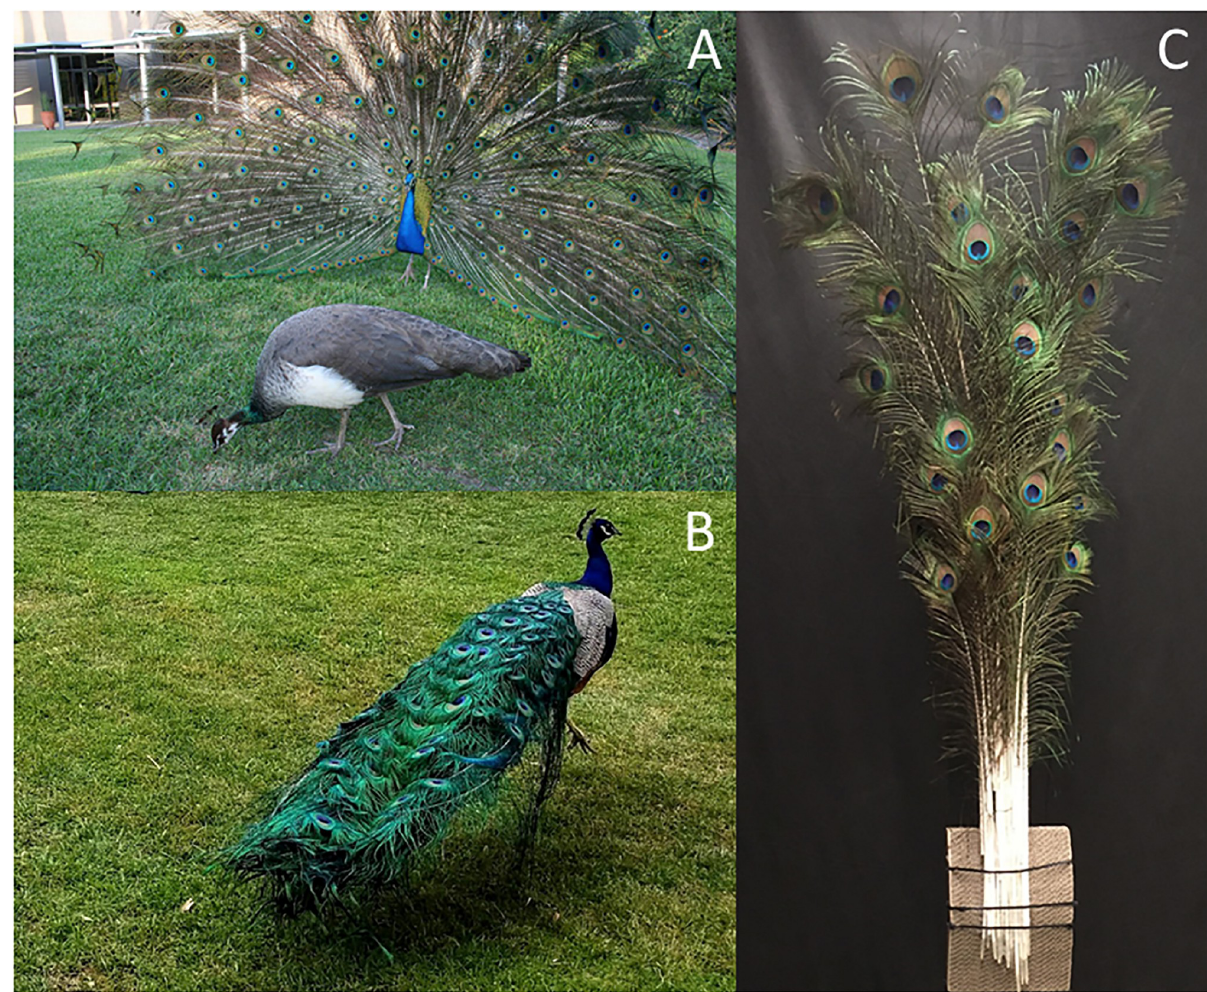
Fig 1. Peacocks and the model peacock train. A) An Indian peacock displaying his erect train to a peahen (female) in the foreground and B) another individual holding his train folded while walking. C) Model peacock train assembled from a collection of eyespot feathers used to evaluate the appearance of the train viewed against